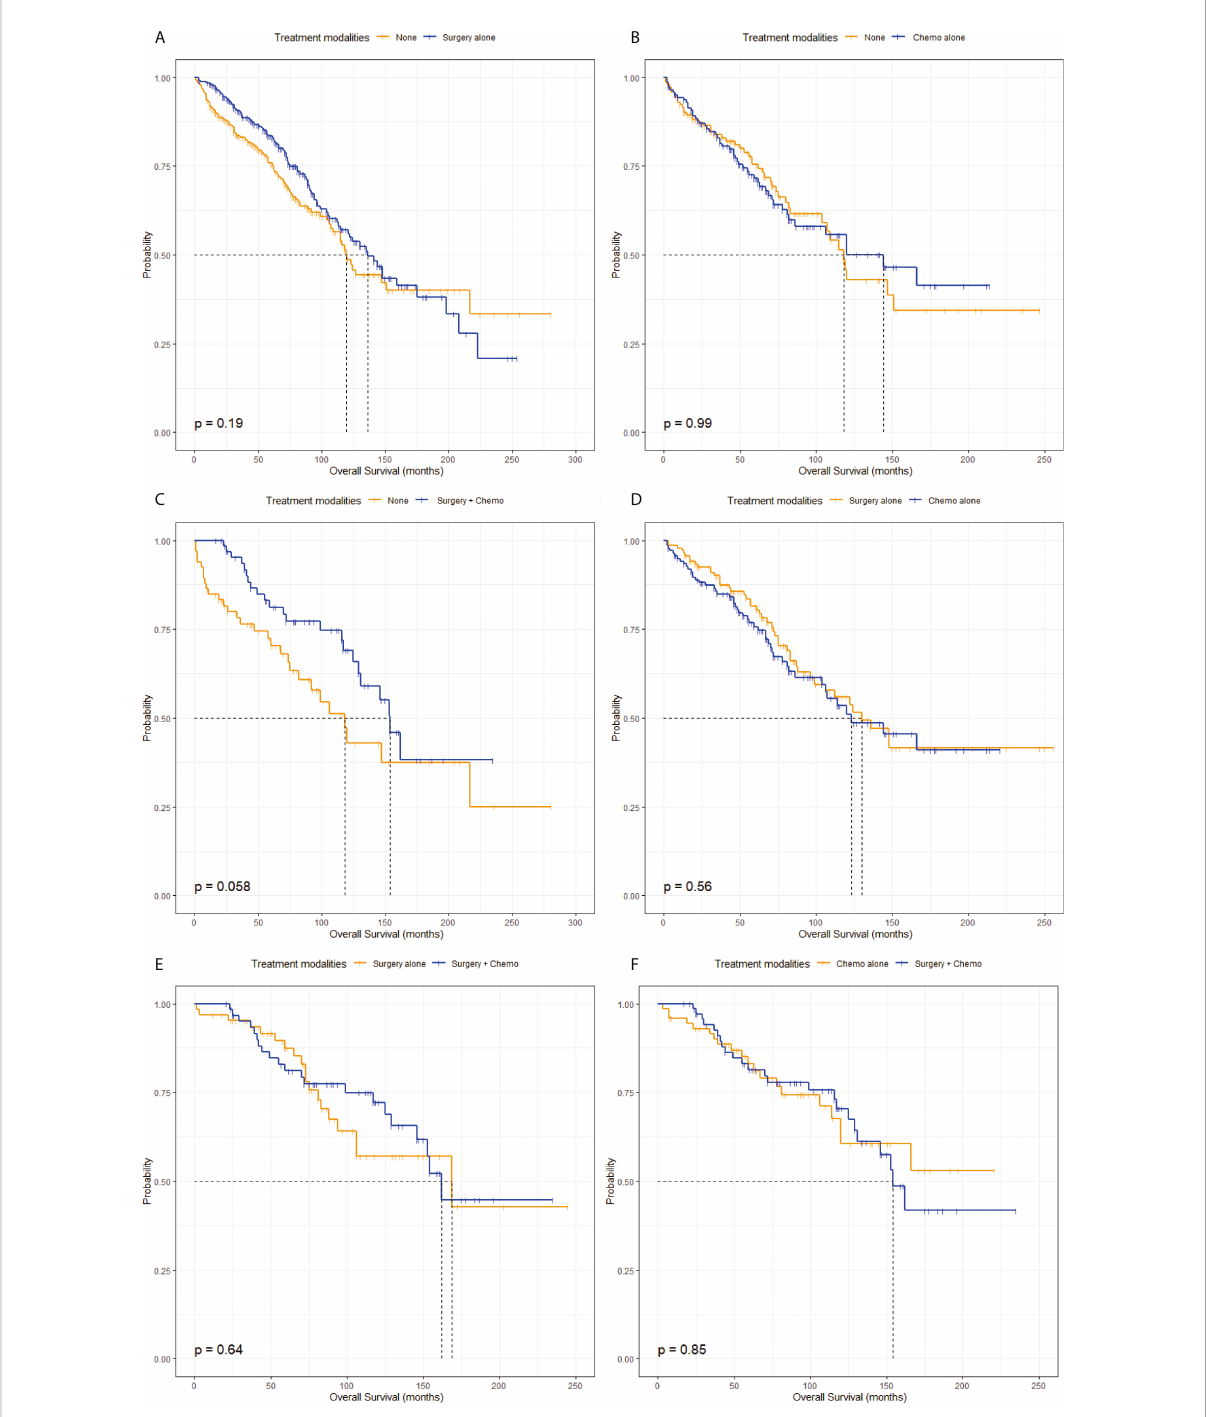
FIGURE 3 Kaplan-Meier survival curves of overall survival strati fi ed by treatment modalities after propensity score-matching. (A) Kaplan-Meier survival curve of overall survival between the None group and the Surgery alone group. (B) Kaplan-Meier survival curve of overall survival between the None group and the Chemo alone group. (C) Kaplan-Meier survival curve of overall survival between the None group and the Surgery + Chemo group. (D) Kaplan-Meier survival curve of overall survival between the Surgery alone group and the Chemo alone group. (E) Kaplan-Meier survival curve of overall survival between the Surgery alone group and the Surgery + Chemo group. (F) Kaplan-Meier survival curve of overall survival between the Chemo alone group and the Surgery + Chemo